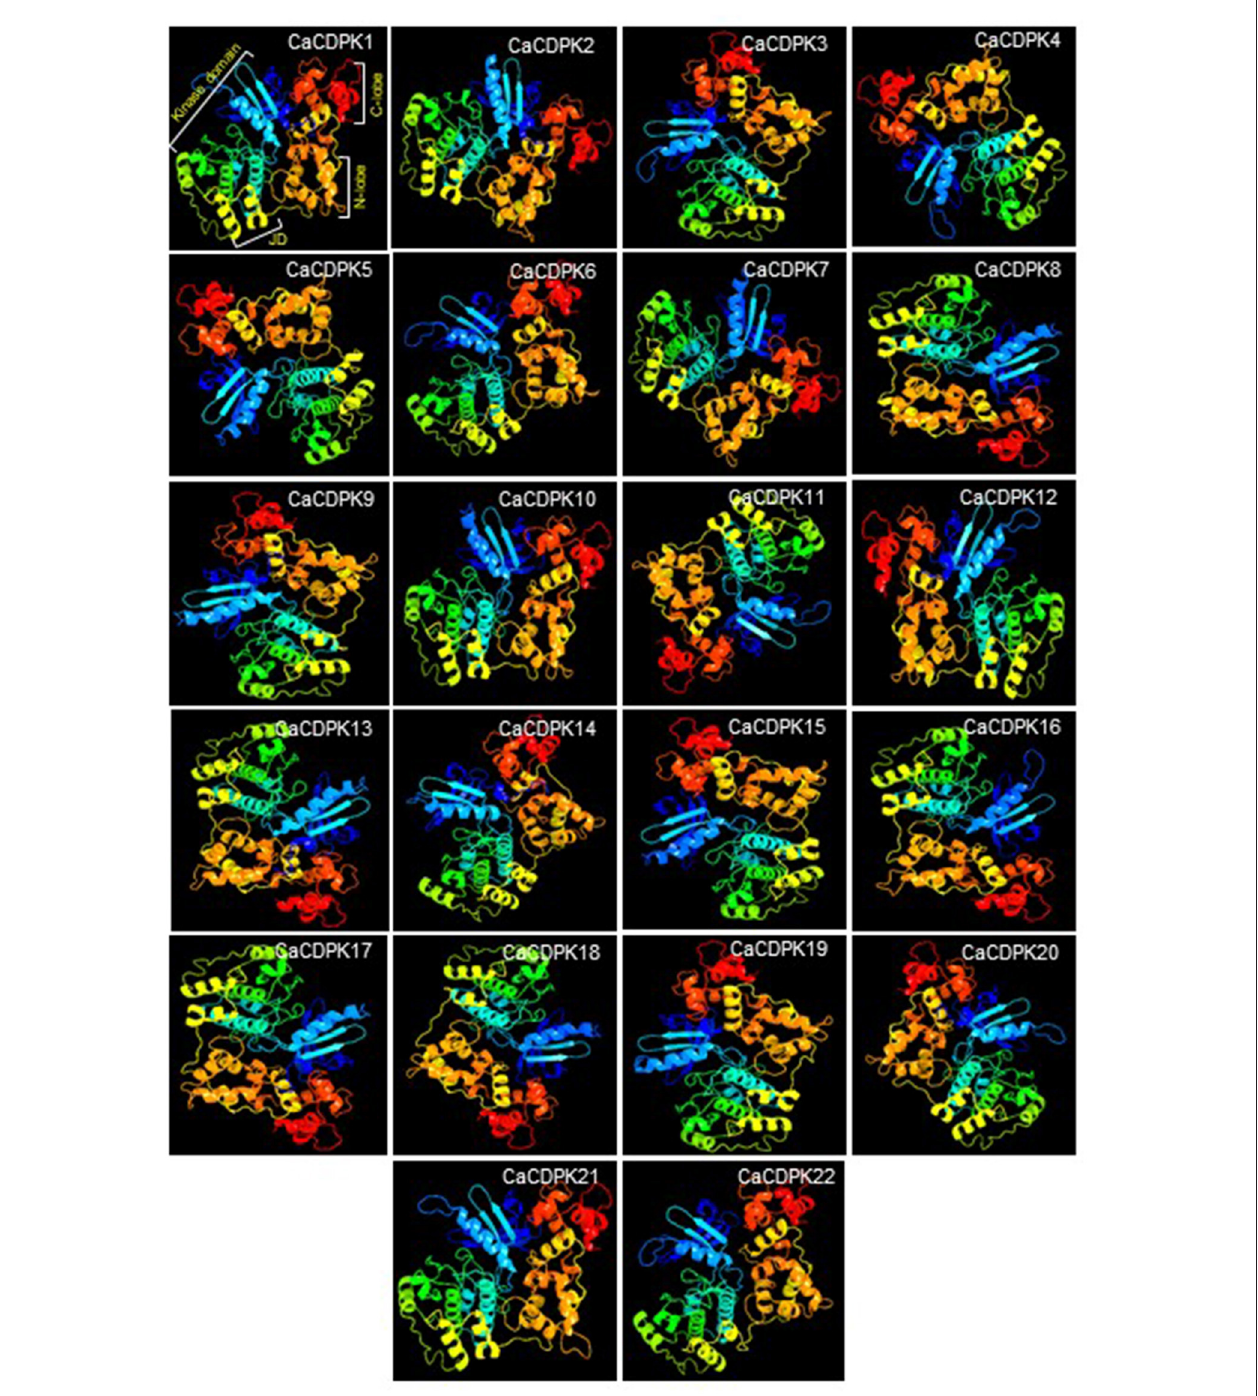
FIGURE 4 | Three-dimensional structure of chickpea CDPK proteins. A three-dimensional (3-D) structure was generated for all 22 members of the chickpea CDPK family. Each CDPK protein is made up of a variable number of α -helix, β -strands, transmembrane helix, and disordered region. Structure comprising blue and green α -helices and β -strands represents kinase domain, yellow helical ribbons represent inhibitory junction domain (JD), orange helices indicate N-lobe, and red helices indicate C-lobe with each containing two elongation factors (EF) hand motifs.